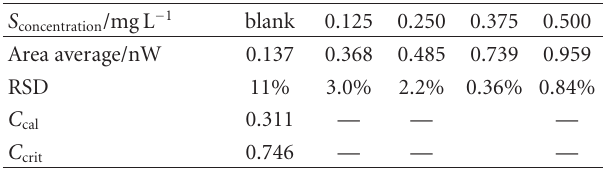
Figure 5: Residue graph obtained from the di ff erences between the values calculated from the straight line of the calibration curve and the values obtained experimentally. Table 2: Linearity study of synthetic samples using elemental sulphur.